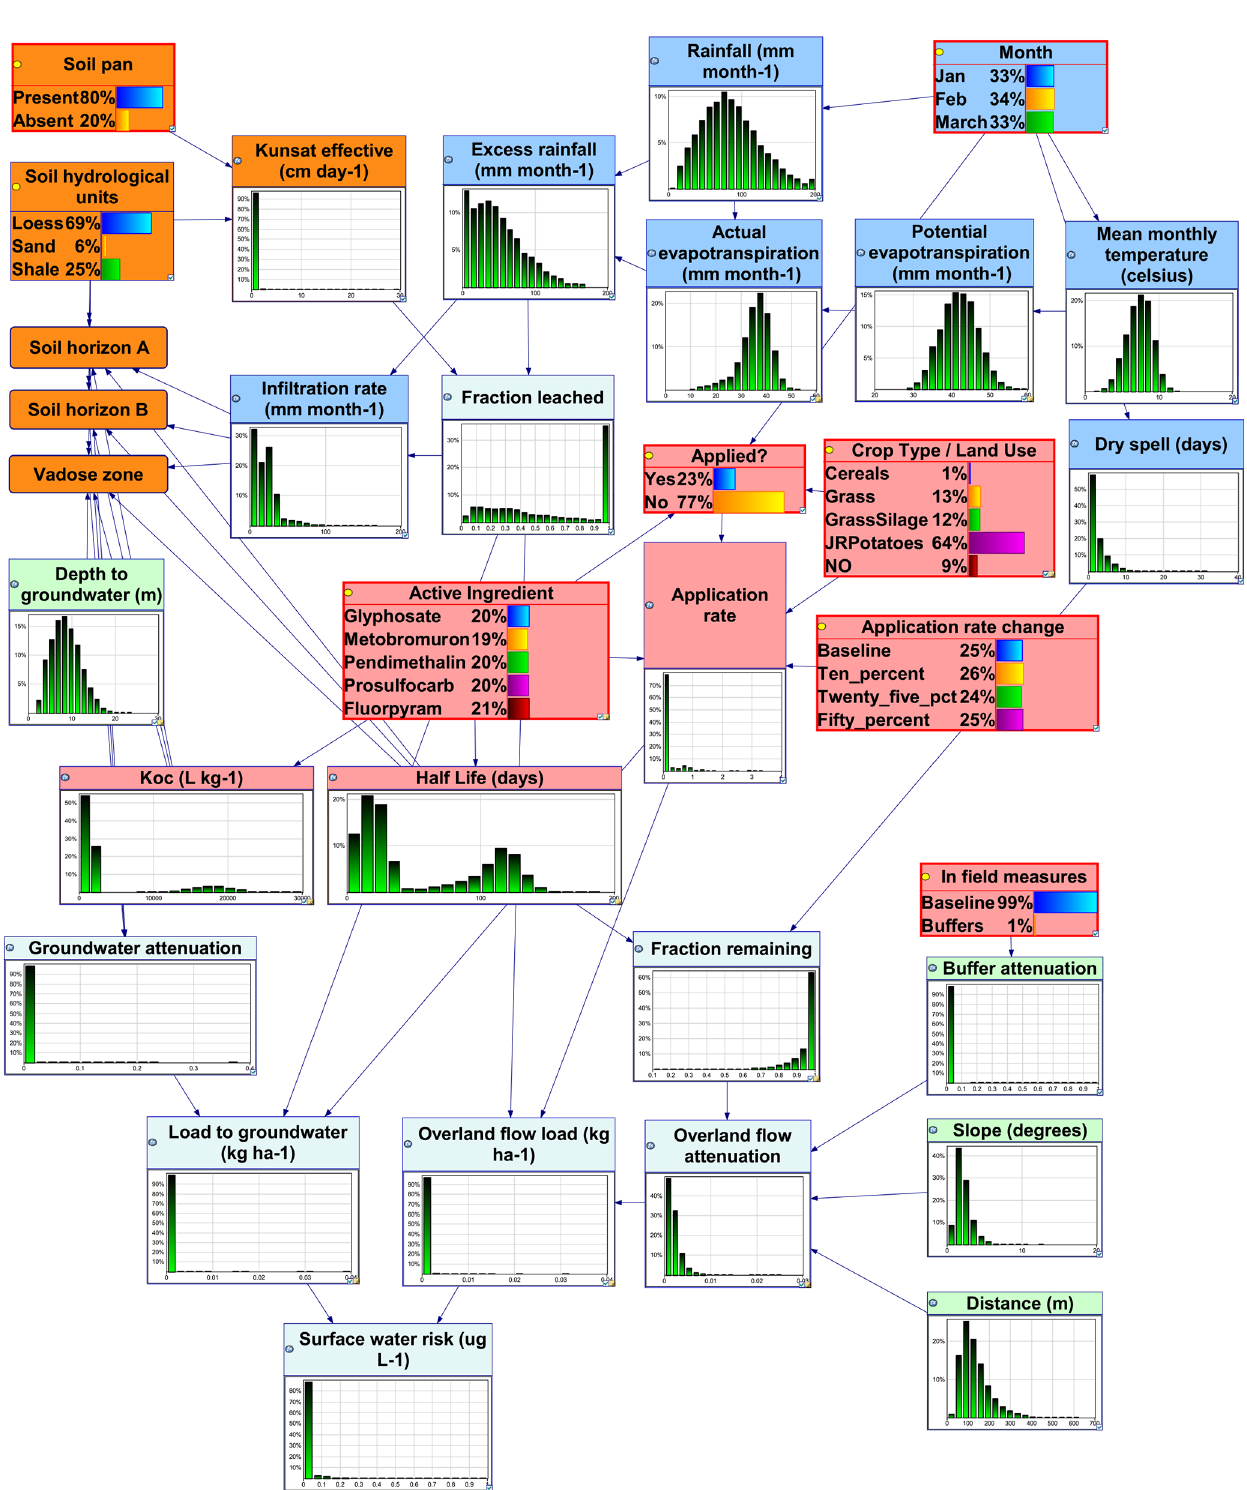
Figure 3. Conceptual structure of the pesticide risk model. Blue: climate/hydrological variables; orange: soil variables; pale green: site- specific variables; red: land-management-/pesticide-specific variables. Nodes with a thick red border show discrete variables that can be manipulated to model management scenarios. Histograms show continuous variables included in the